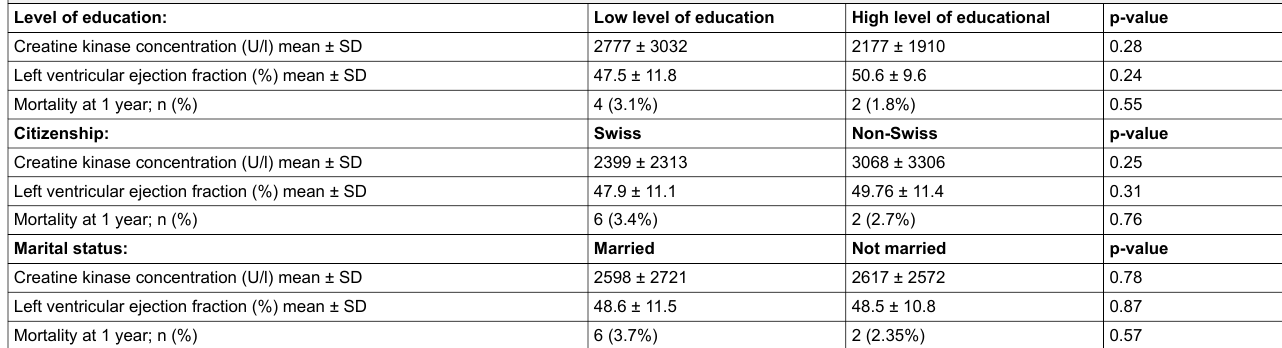
Table 4: Outcome characteristics and scioecenomic factors (n = 222). Level of